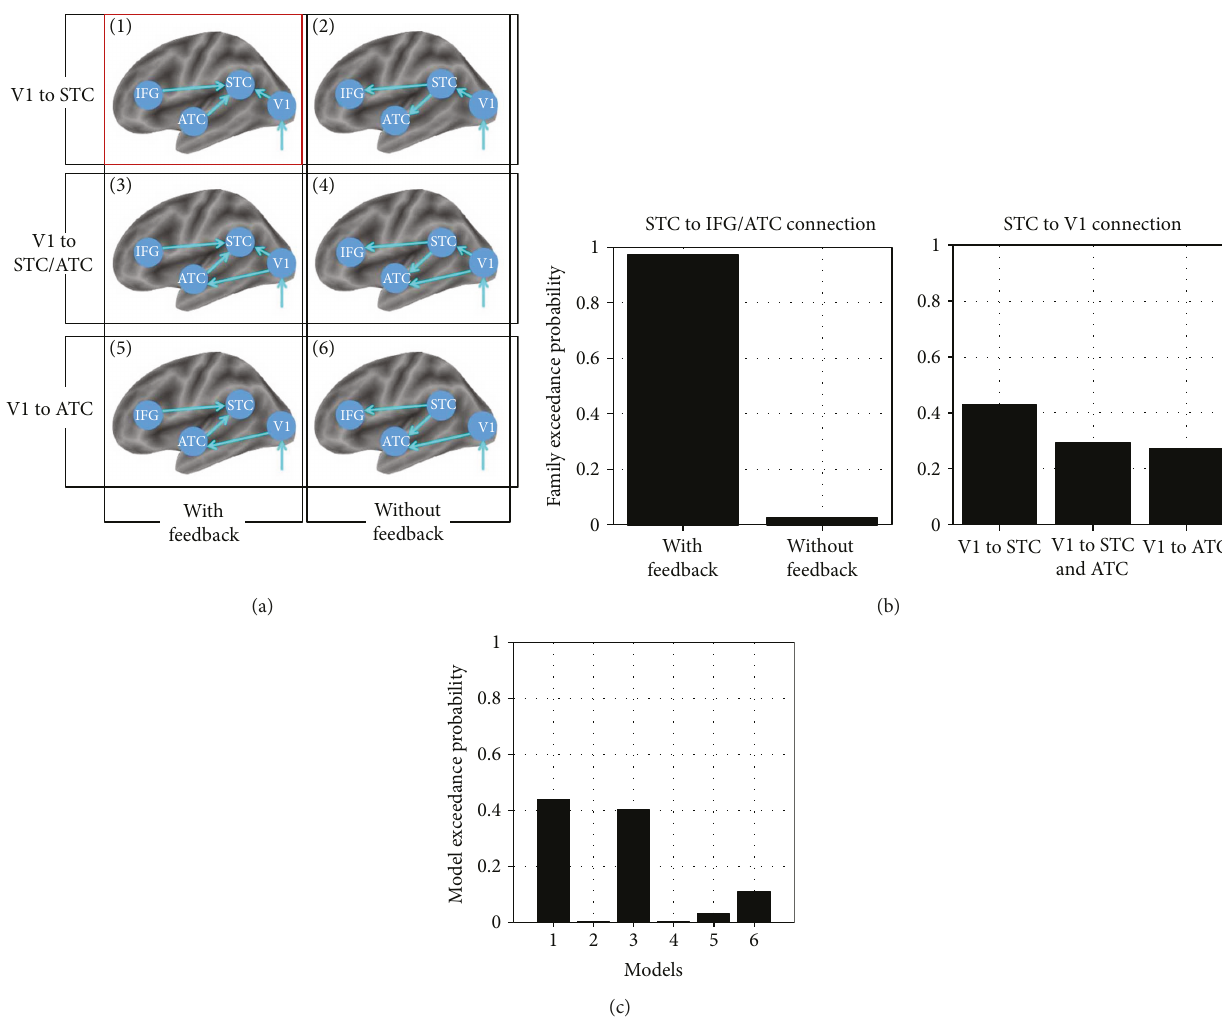
Figure 5: Dynamic causal modeling. (a) The six dynamic causal models used for Bayesian model comparison. Each model receives (parameterized) input at primary visual cortex (V1) source under the language condition in deaf participants. (b) Family-wise Bayesian model selection was used to establish the best neural network architecture for the feedback and feed-forward e ff ect to the STC. Families of models with feedback from IFG/ATC to STC and with feed-forward from V1 to STC/ATC best explained the data. (c) Random e ff ects Bayesian model selection showed model 1 (marked with the red box in (a)) best fi ts the data for the language condition in deaf